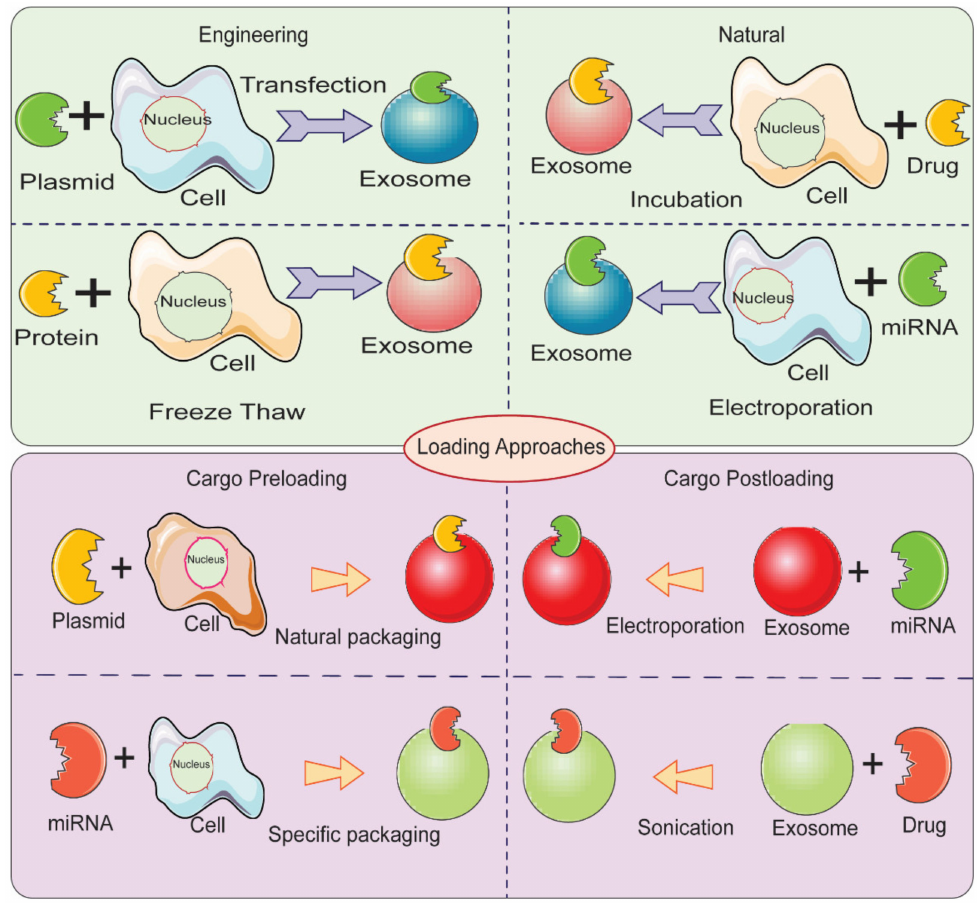
Figure 5. Different methods for loading therapeutic cargos in EVs for developing EV-based delivery